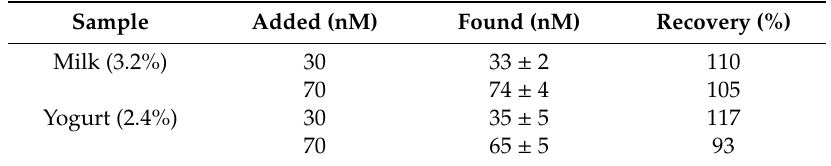
Table 3. The KANA determination in spiked samples of milk and yogurt. Mean ± S.D. for three individual